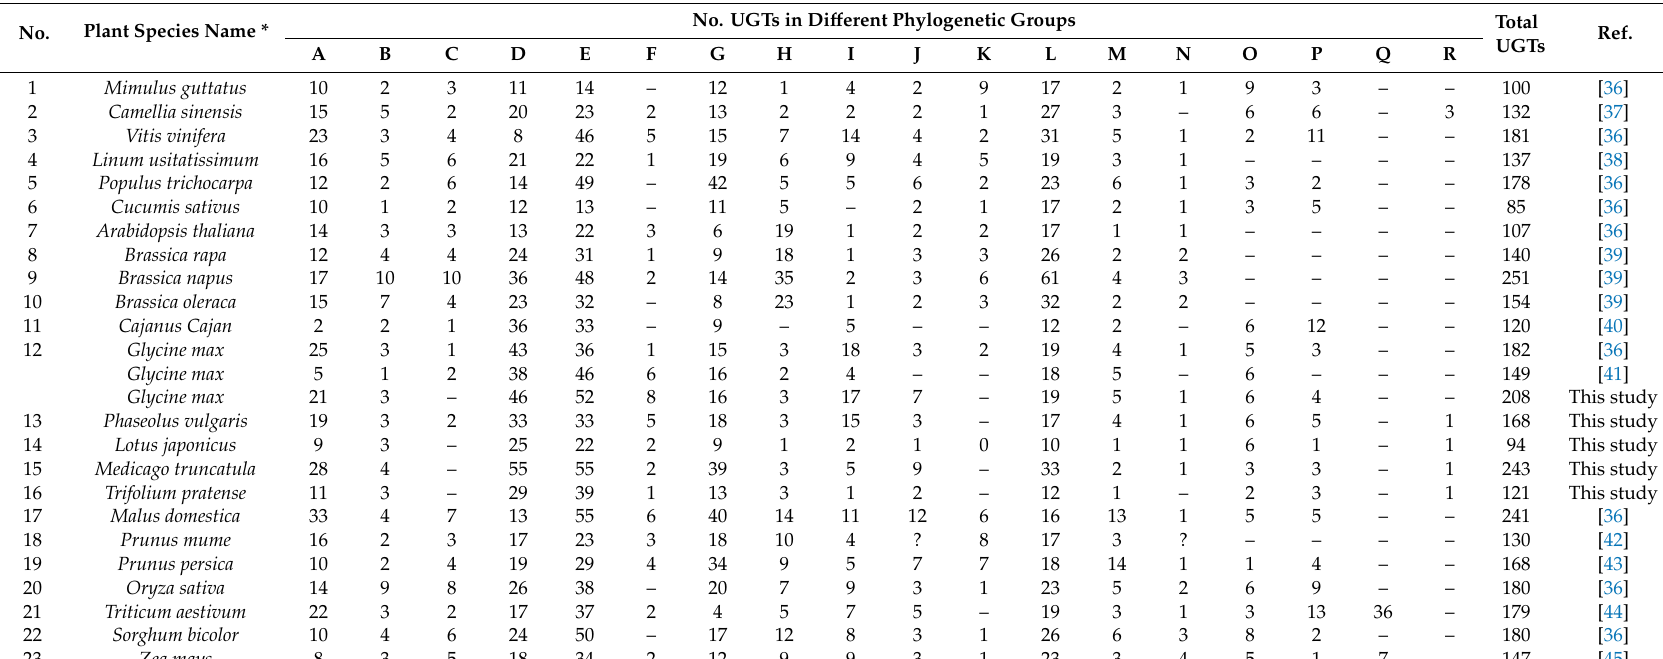
Table 1. Number of plant UGTs in di ff erent phylogenetic